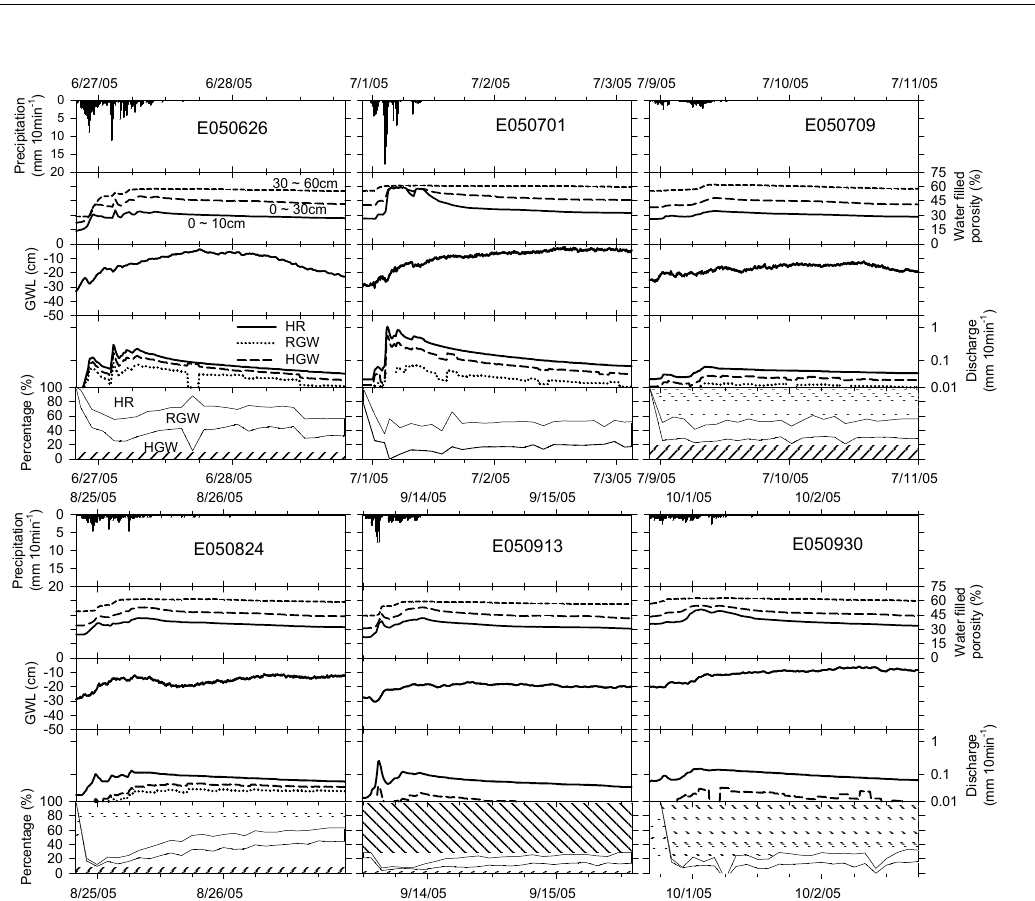
Fig. 2. Temporal variations in precipitation, mean value of water-filled porosity, Groundwater Level (GWL) at R1-G4, stream discharge, and relative contribution of Hillslope Runoff (HR), Riparian Groundwater (RGW), and Hillslope Groundwater (HGW) during the six storm events from June to October